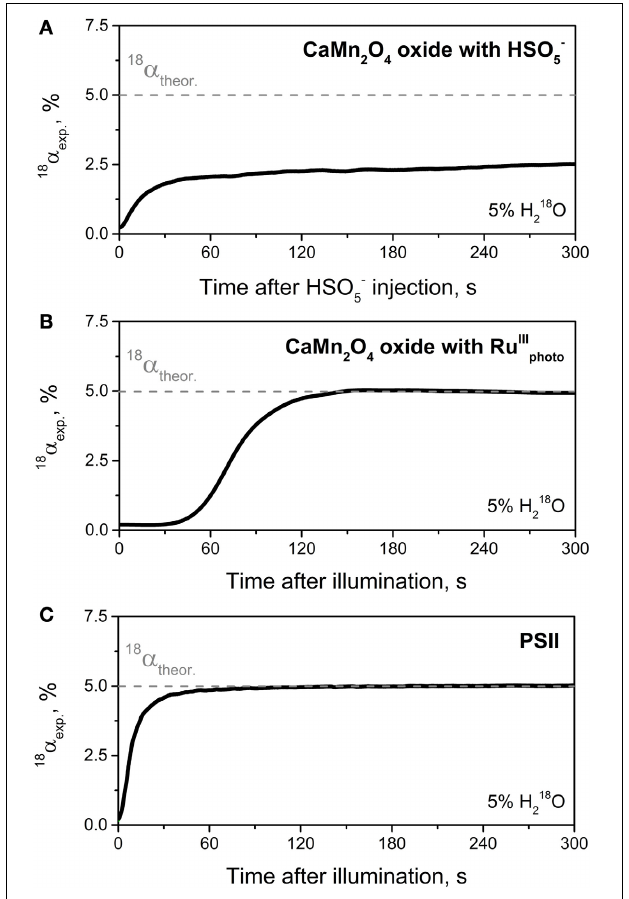
FIGURE 6 | Developmentofthe 18 O-isotopefraction( 18 α